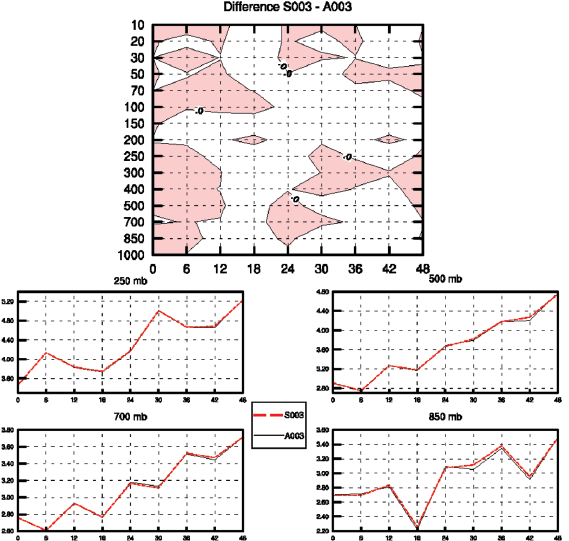
Fig. 18. Top: vertical profile of the wind speed rmse difference be- tween a run with (S003) and without SURFEX (A003) as a func- tion of forecast range averaged over a winter period (10 Decem- ber 2010–29 December 2010) and over the whole domain. Red shaded areas mean that the use of SURFEX improve the scores. Bottom: wind speed rmse of the run with (red line) and without (black line) SURFEX at different pressure levels (250, 500, 700 and 850mb).